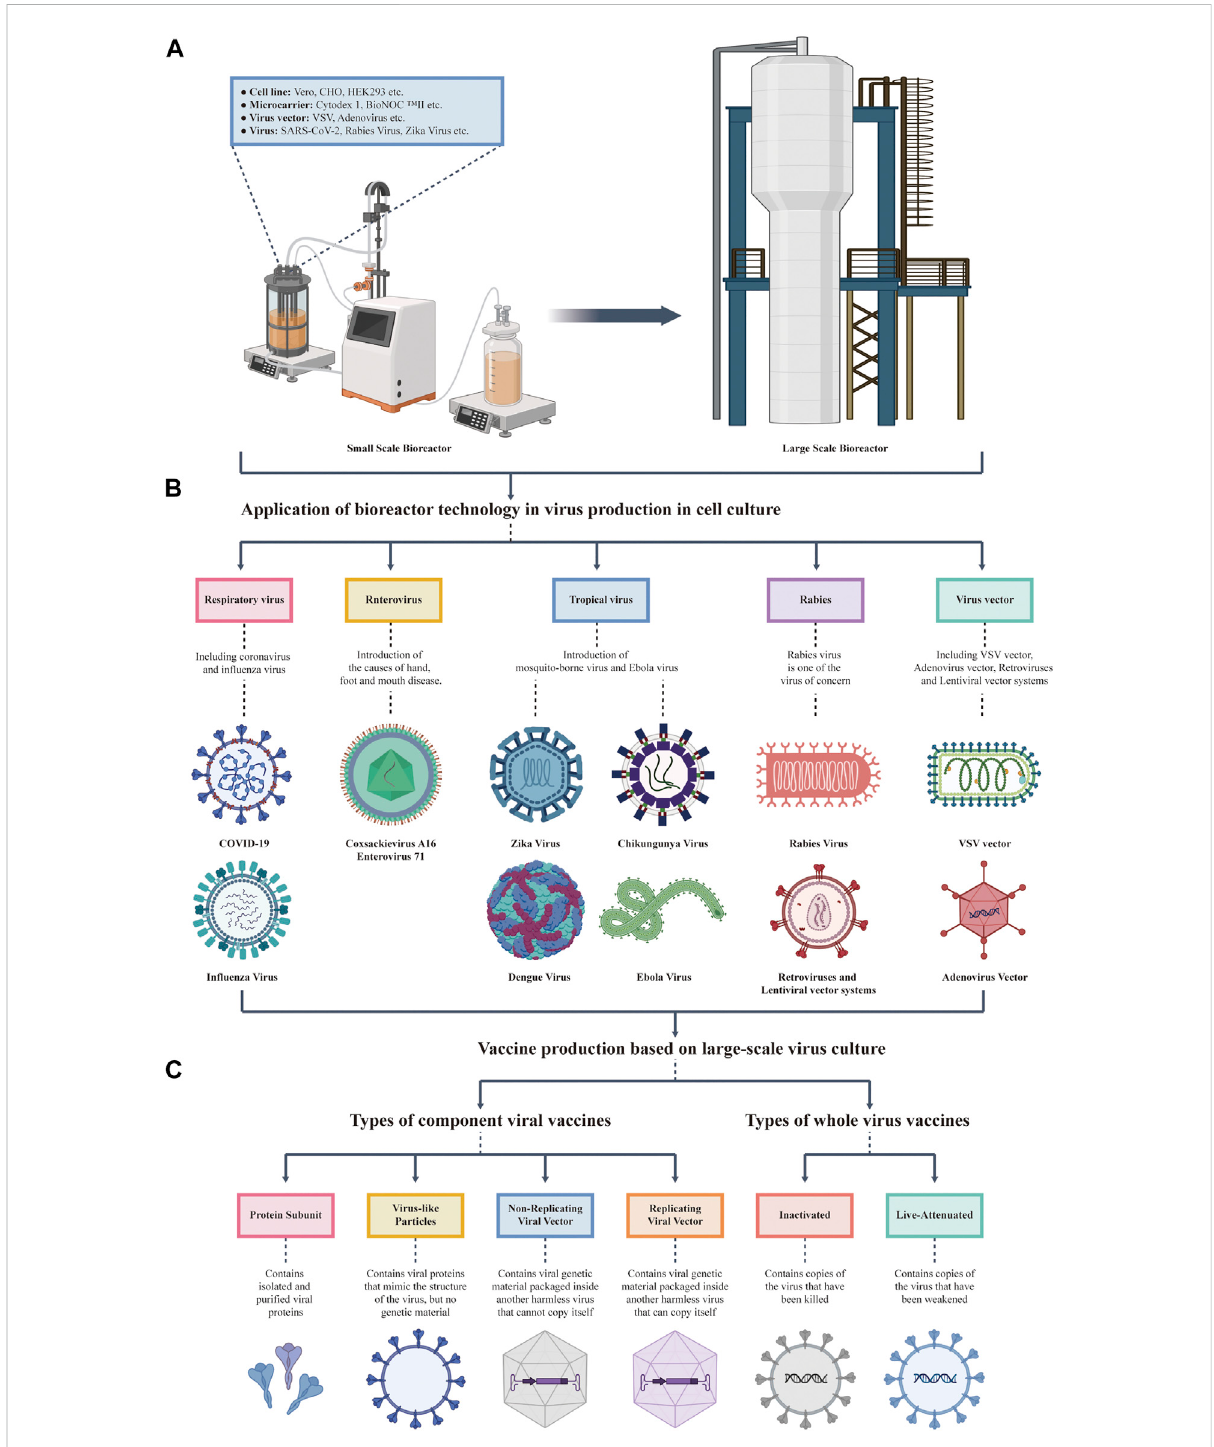
FIGURE 1 Overviewtheupstreamcultureprocessofviralvaccines. (A) Developmentandscale-upofacellculturebioreactor.Theleftplotshowsasmall- scale bioreactor,whichcancontaincelllines, microcarriers,virusvectors,andviruses.Therightplotshows anengineeringgradebioreactorthat can beproducedonalargescaleatonetime. (B) Virusproducedbycell linesinabioreactor.Thetypes ofvirusesproducedbycellculture inabioreactor mentionedinthisreview,includingSARS-CoV-2, In fl uenzaVirus,Tropical Virus,Enterovirus,andRabiesVirus. (C) Vaccineproductionbasedon large-scale virus culture. Bioreactors are mainly used to produce inactivated vaccines, live attenuated vaccines, and several subtypes of vaccines (including protein subunit vaccines, virus-like particles vaccines, and replicating viral vector